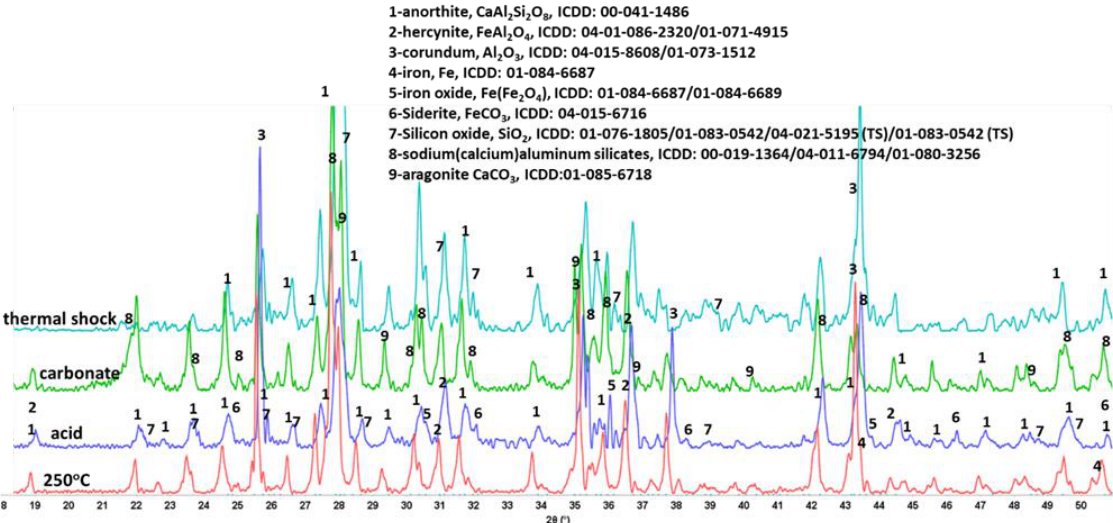
Figure 26. XRD patterns of anorthite samples after the autoclaving at 250 °C, acid-, alkaline carbonate-, and thermal shock tests.